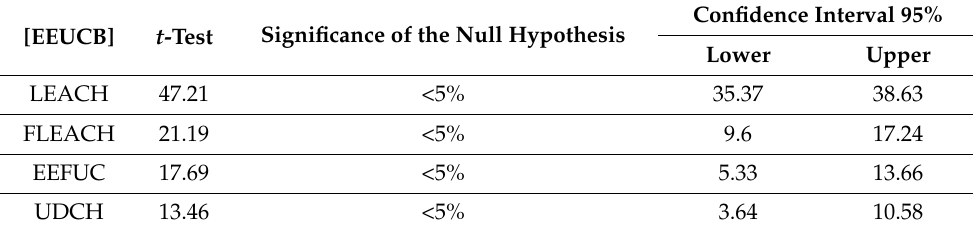
Table 5. Results of t